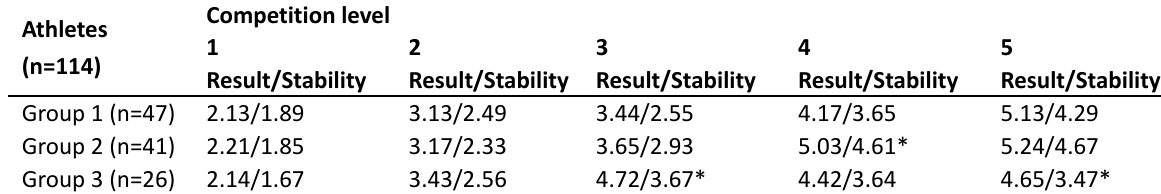
Table 1. The ratio of indicators performance and stability of different athletes’ groups Athletes